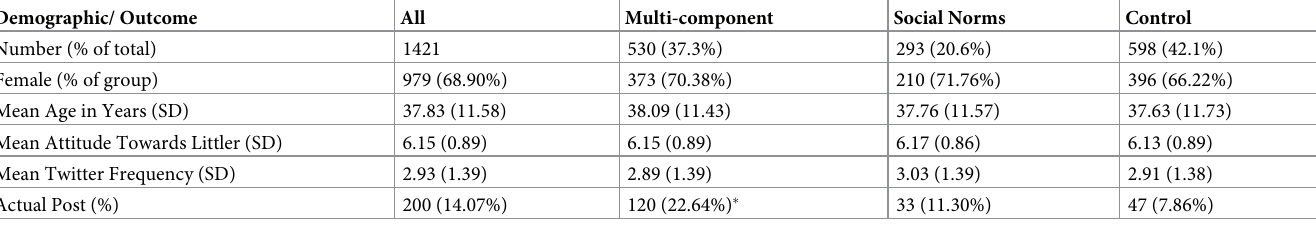
Table 8. Experiment 2-Participant Demographics/Outcome: Evaluative Trial 1 about actual behavior. Demographic/ Outcome